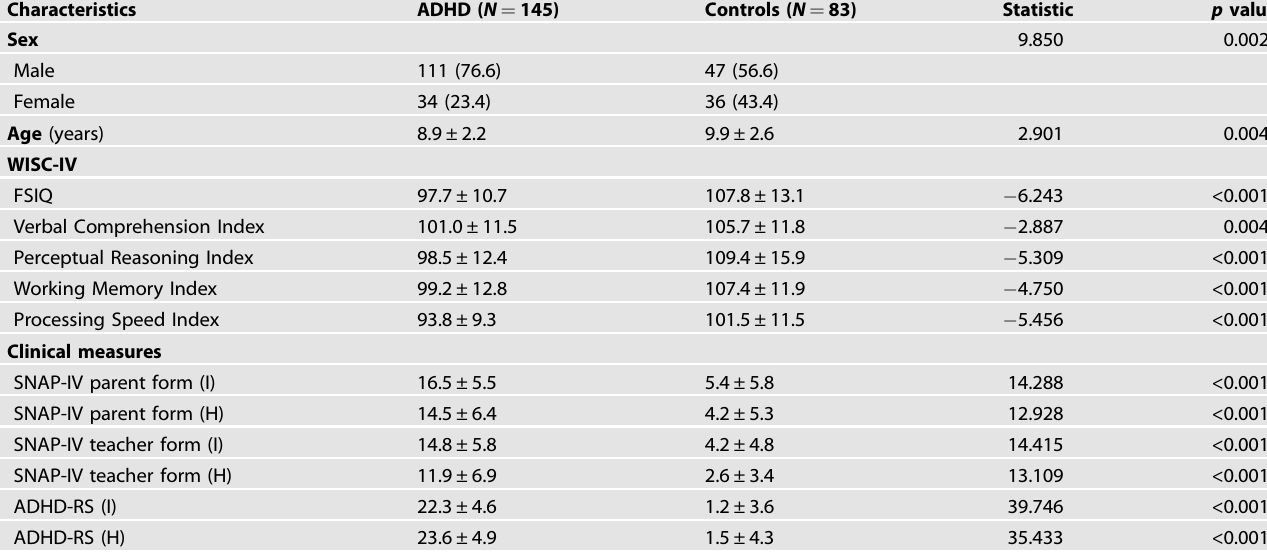
Table 1. Characteristics of patients with ADHD and healthy